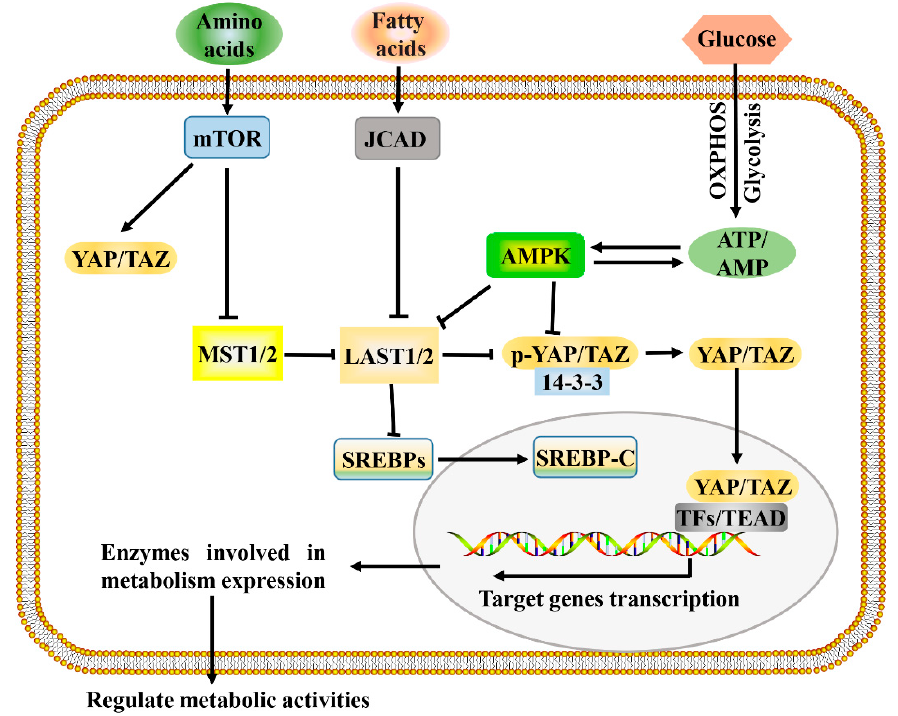
Figure 2. A proposed model for Hippo pathway regulation by metabolism and Hippo pathway targets for metabolism. Metabolism can regulate or be regulated by the Hippo pathway through different mechanisms. In a nutrient-rich environment, glucose through glycolysis and mitochondrial OXPHOS inactivates AMPK by increasing the ATP:AMP ratio; in an energy stress environment, active AMPK inhibits YAP/TAZ by direct phosphorylation and/or activating LATS1/2. Amino acids induce the activation of mTOR, which also activates YAP/TAZ through various mechanisms. Fatty acids increase the expression of JCAD, which inhibits LATS2. Hippo core kinases MST and LATS regulate lipogenesis, as LATS2 can directly bind to SREBP precursors (SREBPs) and inhibit its processing to mature cleaved SREBP (SREBP-C), thus blocking its transcriptional activity. One possible mode of the Hippo pathway regulating metabolism is as follows: Hypo-phosphorylated YAP and TAZ accumulate in the nucleus, where they can bind to various TFs (such as HIF1 α and SREBP) or TEAD family, to direct transcription and expression of enzymes involved in complex metabolic pathways. AMPK, AMP-activated protein kinase; JCAD, junctional protein associated with coronary artery disease; LATS, large tumor suppressor; MST, mammalian sterile 20 like; OXPHOS, oxidative phosphorylation; SREBP, sterol regulatory element-binding protein; TEAD, TEA domain protein; TFs, transcription factors; YAP/TAZ, yes-associated protein/transcriptional coactivator with PDZ-binding motif.